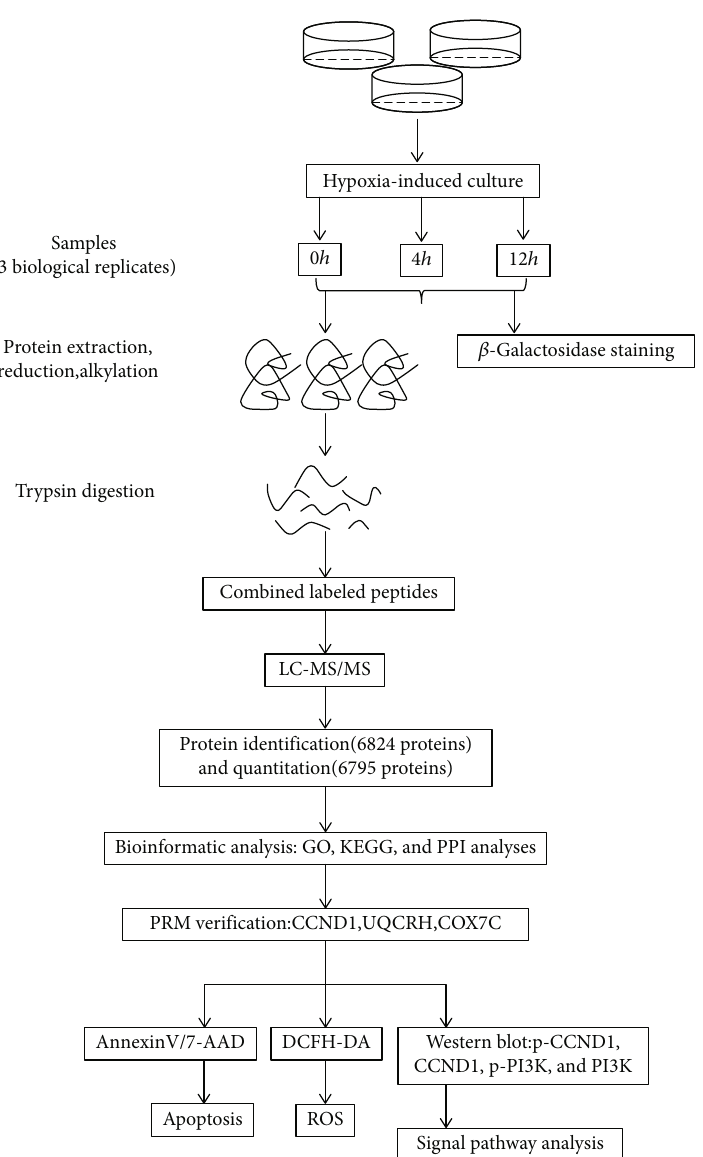
Figure 1: The complete experimental process. Hypoxia in hBMSCs was induced for 0, 4, and 12 hours, and cellular senescence was evaluated by senescence-associated β -galactosidase (SA- β -gal) staining. TMT quantitative proteomic analysis with LC-MS/MS analysis was performed to identify and quantify proteins. The general characterization of enriched proteins was performed by GO, KEGG, and PPI network analyses. PRM analysis was used to validate the candidate proteins (CCND1, UQCRH, and COX7C) with changes in expressions. Cell apoptosis was evaluated using Annexin V/7-AAD staining by fl ow cytometry. ROS was detected by the fl uorescent probe DCFH-DA. Veri fi cations of signaling pathways were evaluated by western